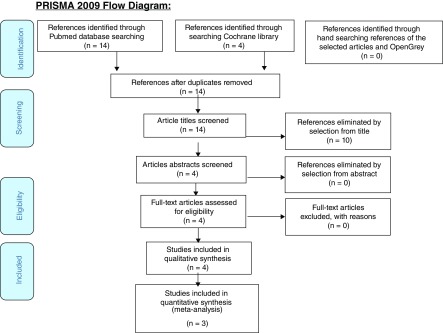
PRISMA Flow diagram.